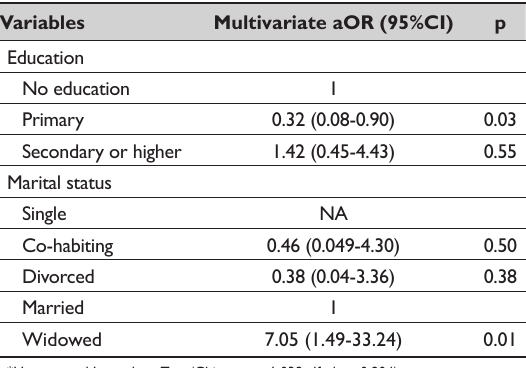
Table 3: Multivariate associations (multiple logistic regression) between maternal socio-demographic factors and children’s HIV